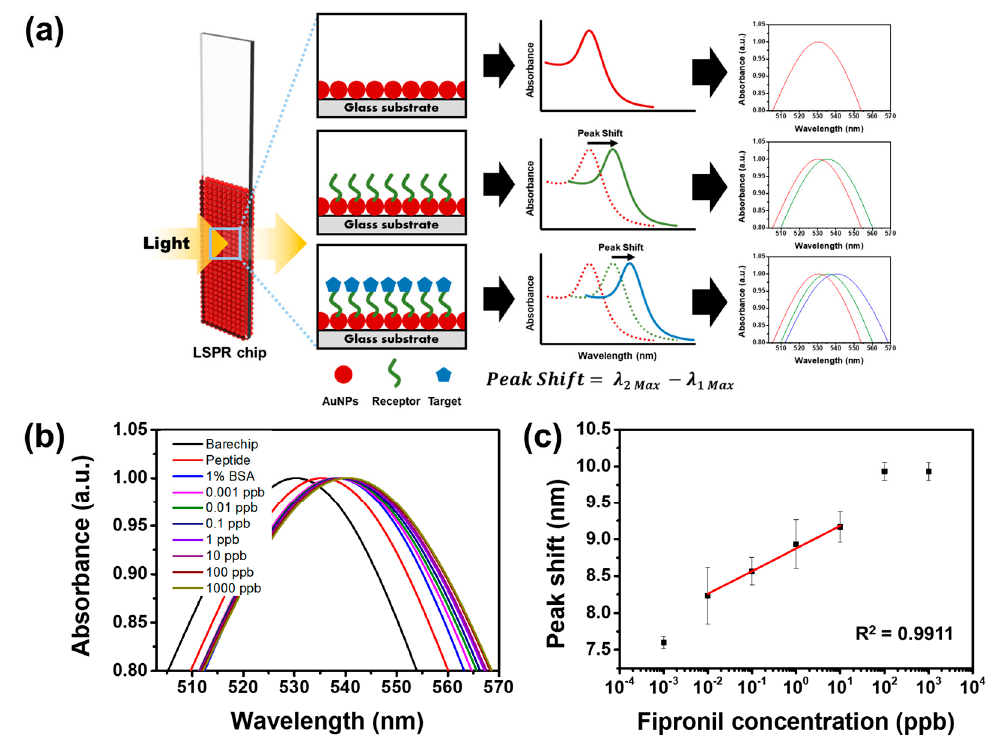
Figure 3. Detection of fipronil standard solution with high sensitivity through optimized LSPR sensor chip: ( a ) peak shift observed as the Au NPs bind, peptide binds, and fipronil binds; ( b ) sensitivity of LSPR sensor chips under various concentrations of fipronil standard solutions, confirmed with UV– Vis spectrum; and ( c ) changes in the spectrum peak at different concentrations of fipronil standard solution reacted on the chip.